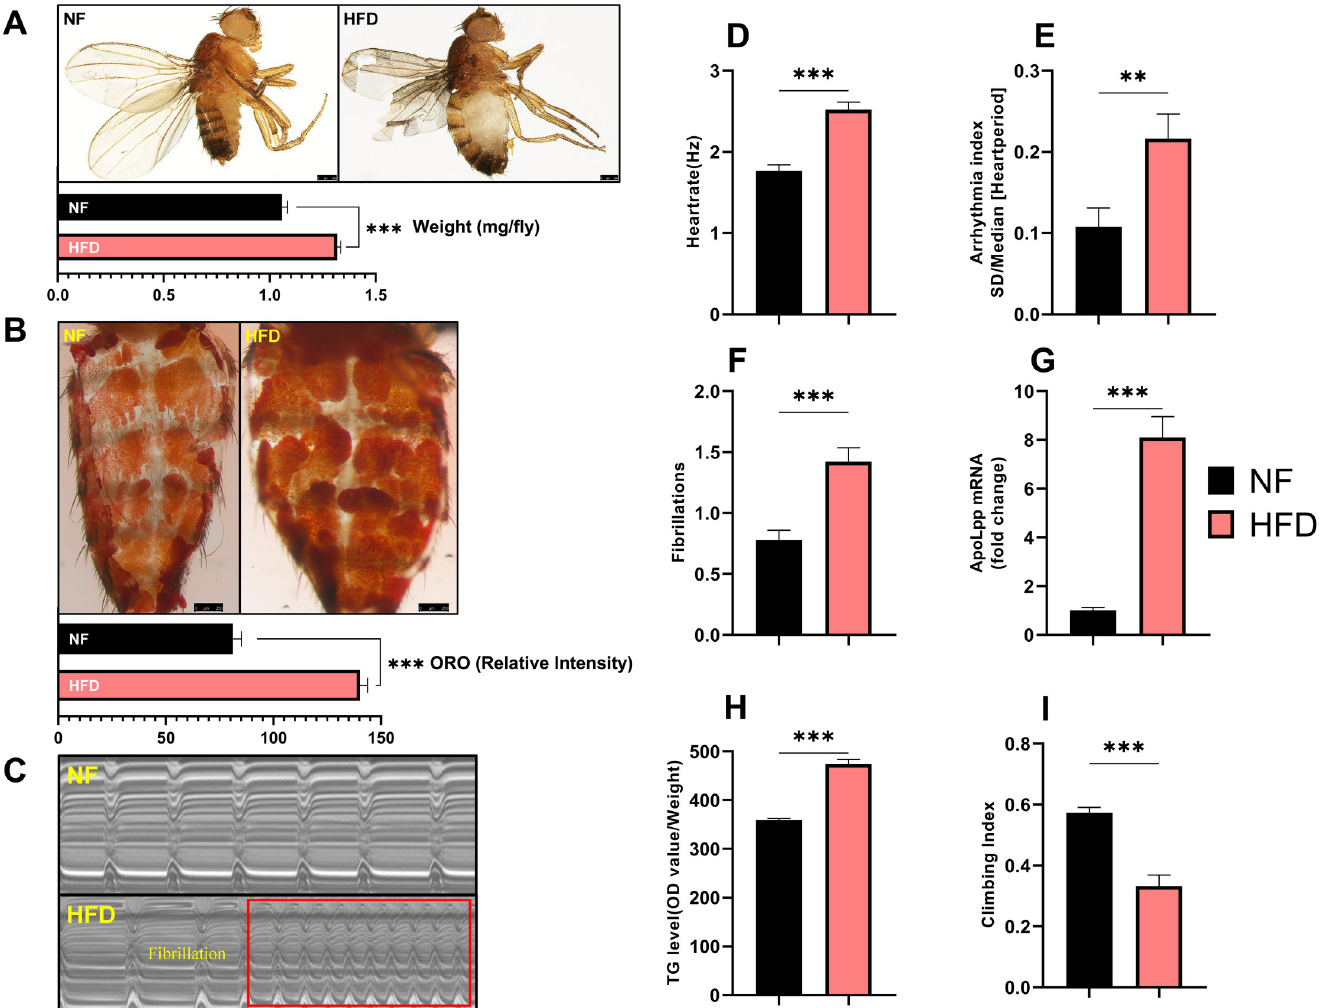
Fig 1. UAS-apoLpp RNAi > W 1118 group was exposed to HFD for 5 days, resulting in obesity and abnormal heart rhythm. (A) Photographs and body weights of 10-day-old flies. The body weight was obtained by weighing flies on an electronic microbalance, N = 15. The flies in the HFD group were heavier compared to the NF group. (B) ORO staining of the abdomen of flies. Quantification of ORO intensity, N = 5. (B) ORO staining of fly abdomens. Quantification of ORO intensity, N = 5. The intensity of ORO staining in the abdomen of flies in the HFD group was higher, compared to the HF group. (C) Drosophila M-mode cardiogram, the red rectangle represents fibrillation, and the interception length is 10 s (This refers to the length of the electrocardiogram of 0–10 s). (D-F) M-Mode analysis. Quantification of the fly heart rate, arrhythmia index, and fibrillation, N = 30. The heart rate, arrhythmia index, and fibrillation of flies in the HFD group were higher than those in the NF group. (G) The relative expression level of apoLpp in cardiomyocytes of flies. The apoLpp in the cardiomyocytes of flies in the HFD group was significantly greater than in the NF group. The samples included at least 60 isolated hearts. (H) Whole-body TG levels in flies. The whole-body TG level of the HFD group was significantly higher than that of the NF group. N = 5, repeated three times. (I) Drosophila climbing index. The climbing index of the HFD group was significantly less than that of the NF group. The climbing index = number of flies at the top/total number of flies, N = 50, repeated three times. The detailed method is given in the (S2